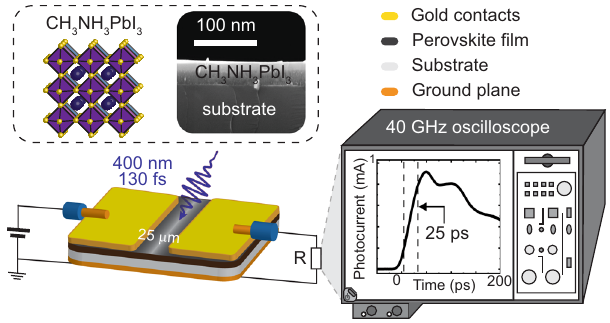
Fig. 1 Experimental schematic setup of UPCS. The thin fi lm perovskite photoconductive device is integrated into a microstrip transmission line structure to have a sub-25 ps time resolution ultrafast photocurrent, which is collected by a sampling oscilloscope. The ultrafast laser pulse duration is 130 fs. The top left panel is the MAPbI 3 lattice structure and thin fi lm cross section SEM image on glass